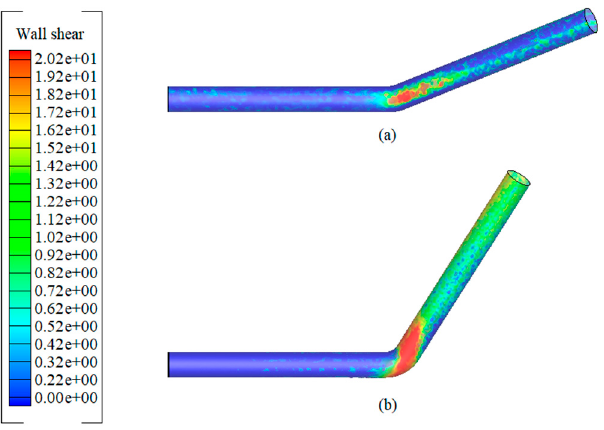
Figure 9. Contours of the wall shear stress at different inclined angles when the fluid contains 30% water–70% gas and the gas superficial velocity is 3 m/s, respectively: ( a ) 30° and ( b ) 60°.